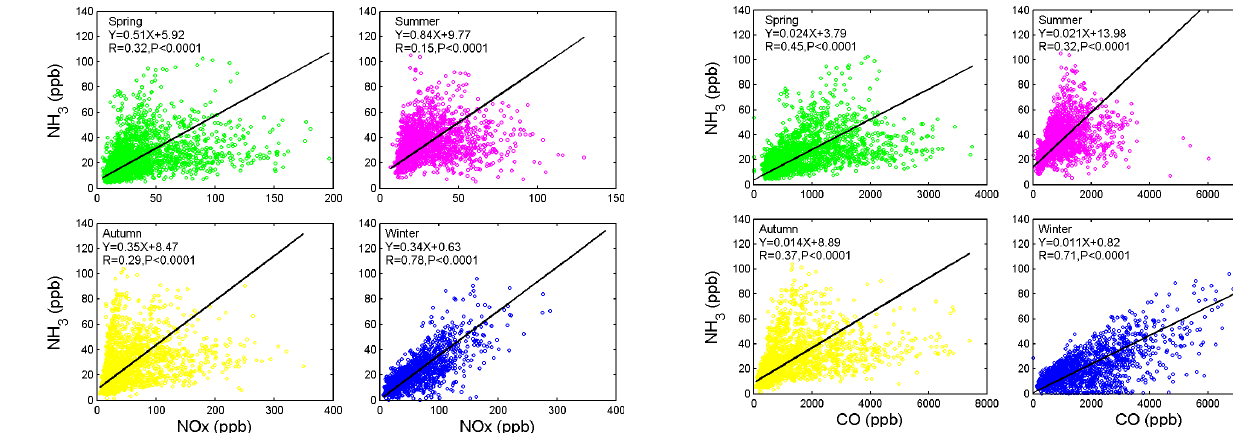
Fig.7 The 2-sided regression of NH 3 versus NOx at CMA in different seasons from June 2009 to May Fig. 7. The 2-sided regression of NH 3 versus NO x at CMA in dif- ferent seasons from June 2009 to May 2010. 2010.